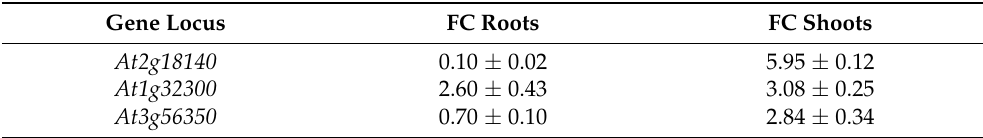
Table 6. Validation of gene microarrays by qPCR. Fold change of NNMF expression vs. GMF expression of Arabidopsis thaliana exposed for 96 h. Values are expressed as means of at least three biological replicates ( ± standard deviation).